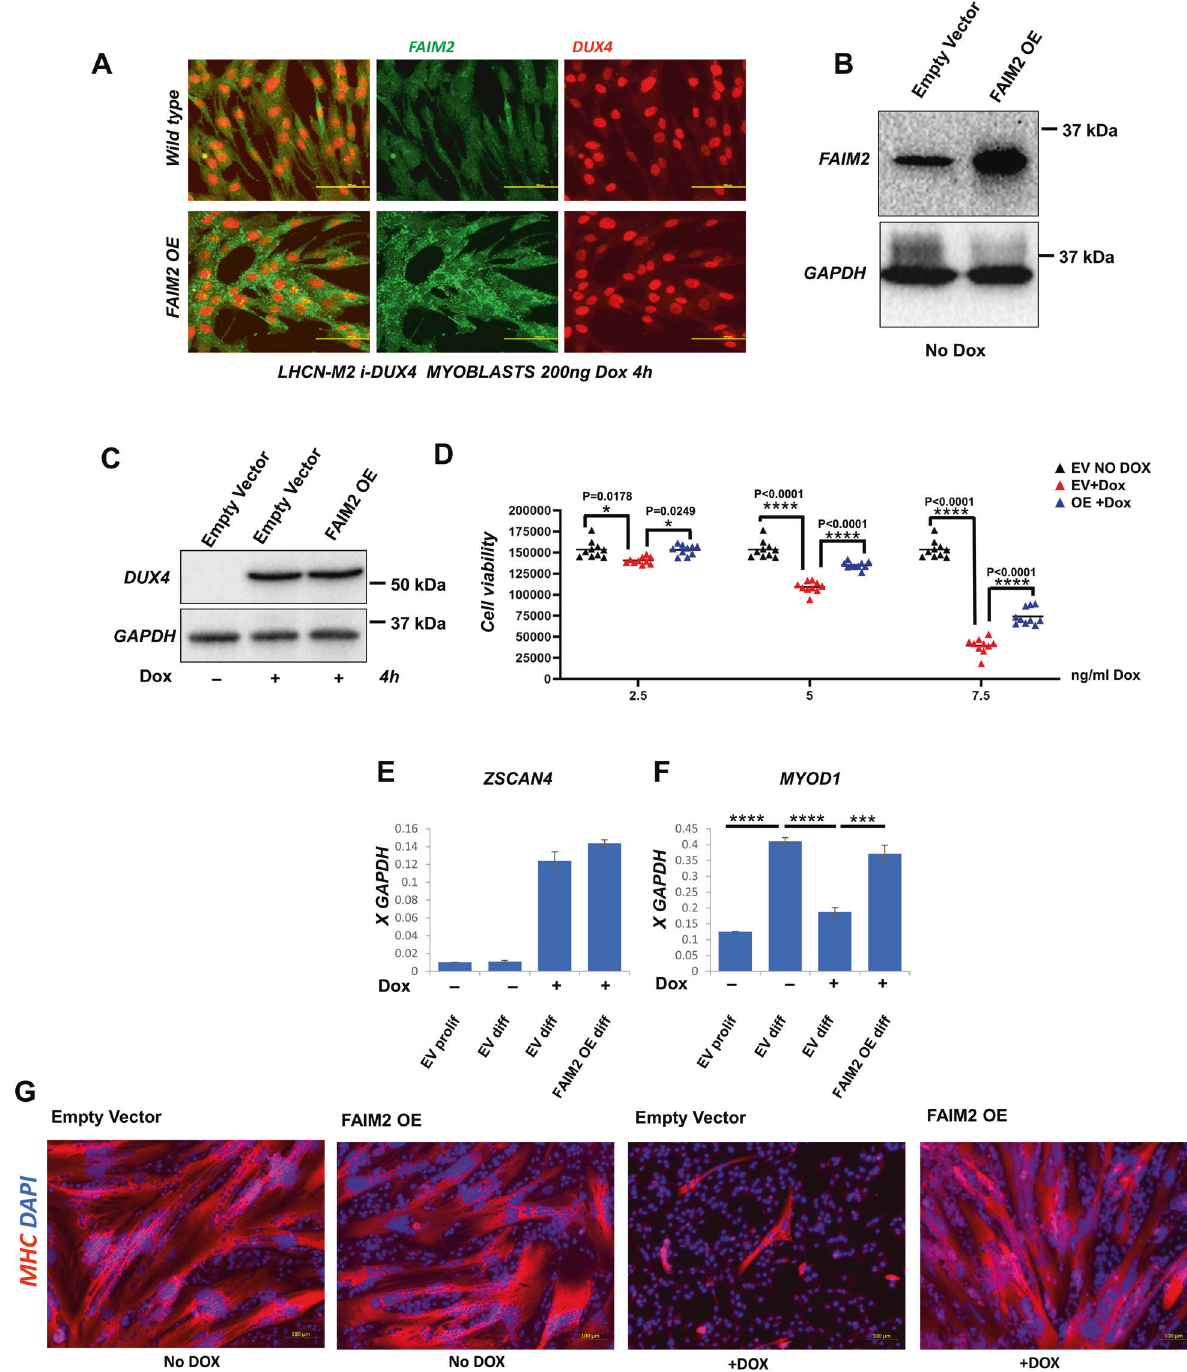
line. This was con fi rmed by TUNEL assay (Fig. 5C, D). As with siRNA-treated myoblasts, shRNA-expressing myoblasts showed severely impaired differentiation (Fig. 5E), in this case with a more signi fi cant reduction in MYOD1 and MYOGENIN levels, and a failure to upregulate both with differentiation (Fig. 5F –